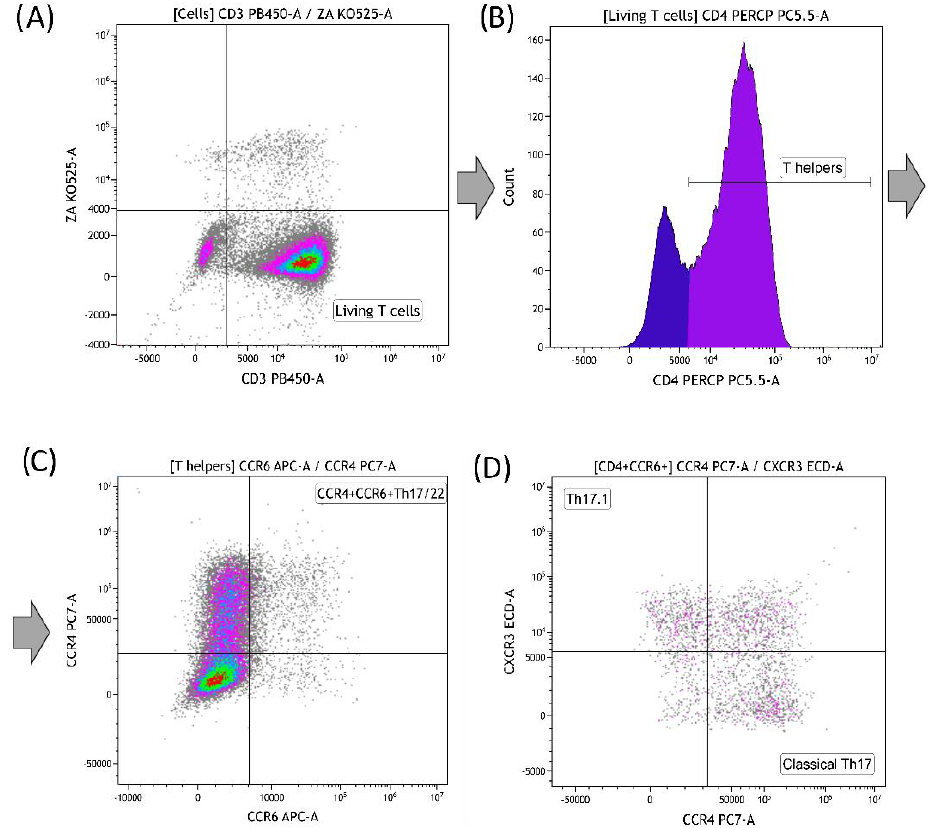
Figure 3. ( A – C ) Gating strategy of the Th17/22 subpopulation. (( A ) live T cells; ( B ) T helpers; ( C ) Th17/22); ( D ) gating strategy of Th17 subpopulations (17.1 and “ classical ”